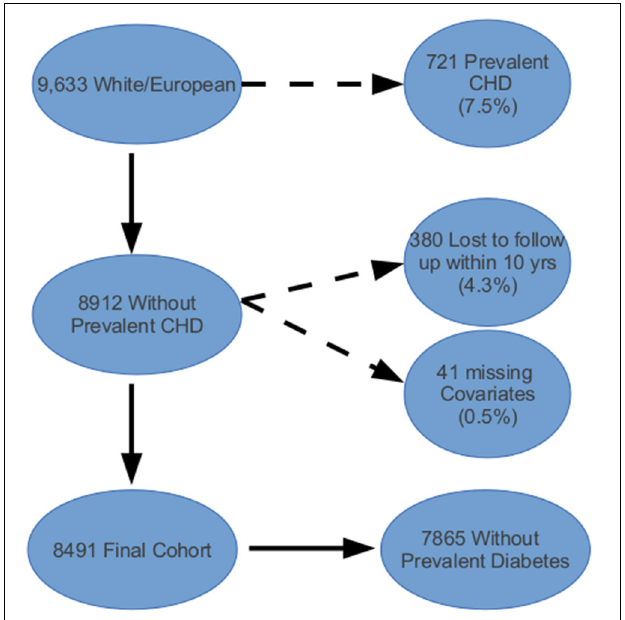
FIGURE 1 | Atherosclerosis Risk in Communities (ARIC) cohort inclusion and exclusion criteria applied to data obtained from the NCBI’s database of genotypes and phenotypes